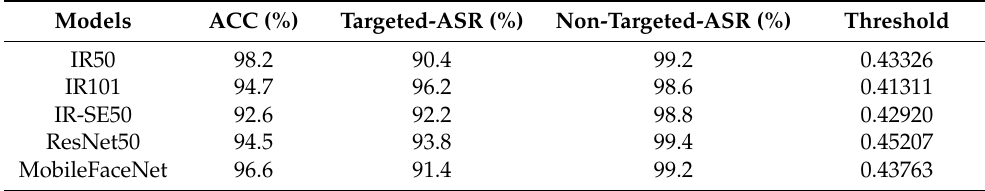
Table 2. The accuracy and success rates of different models under the specified